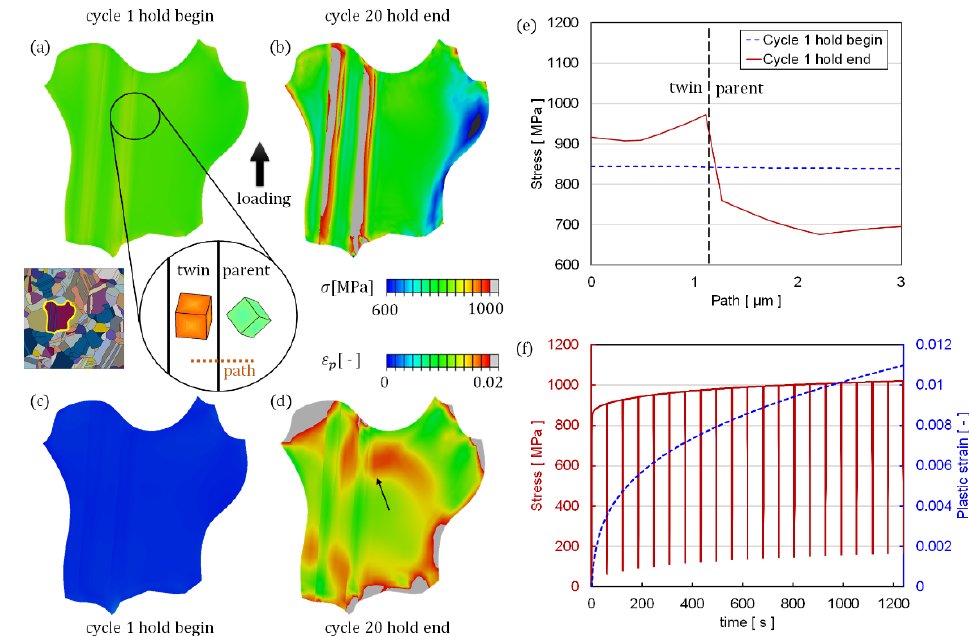
Figure 5. Microscopic stress and strain evolutions in S4 specimen under dwell fatigue loading. ( a , b ) Stress distributions along the loading direction. ( c , d ) Effective plastic strain distributions. ( e ) Load shedding along the path as sketched in ( a ). ( f ) Peak stress and plastic strain evolution with cycles.